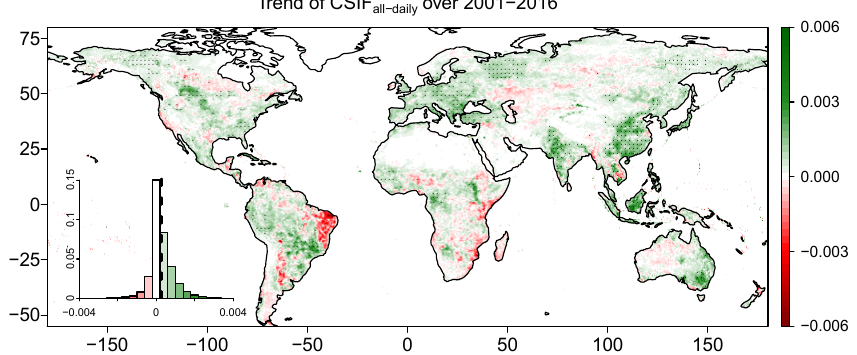
Figure 8. Trend of annual average CSIF all-daily during 2003–2016. The trend is calculated by the Sen’s slope estimator. Dots represent the trend is significant ( p< 0 . 05) through a Mann–Kendall test. The inset in the bottom left shows the histogram of the CSIF all-daily trend. Dashed vertical line represents the average trend. Barren areas with an annual average CSIF all-daily smaller than 0.006mWm − 2 nm − 1 sr − 1 are screened from analysis. Trends are in units of mWm − 2 nm − 1 sr − 1 yr − 1